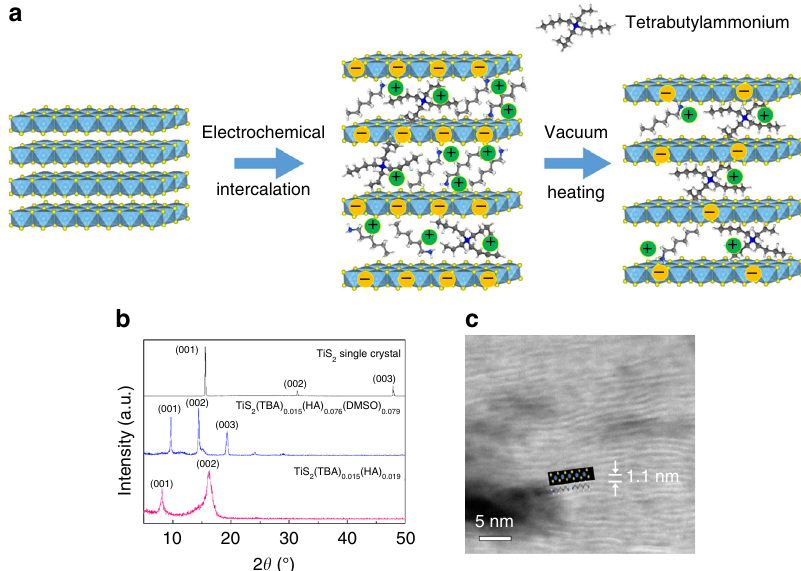
Fig. 3 a Evolution of structure and carrier concentration of TiS 2 single crystal with the electrochemical intercalation of HA/TBA molecules and vacuum heating. b XRD patterns of TiS 2 single crystal, TiS 2 (TBA) 0.015 (HA) 0.074 (DMSO) 0.079 and TiS 2 (TBA) 0.013 (HA) 0.019 . c Magni fi ed HAADF-STEM image of TiS 2 (TBA) 0.013 (HA)